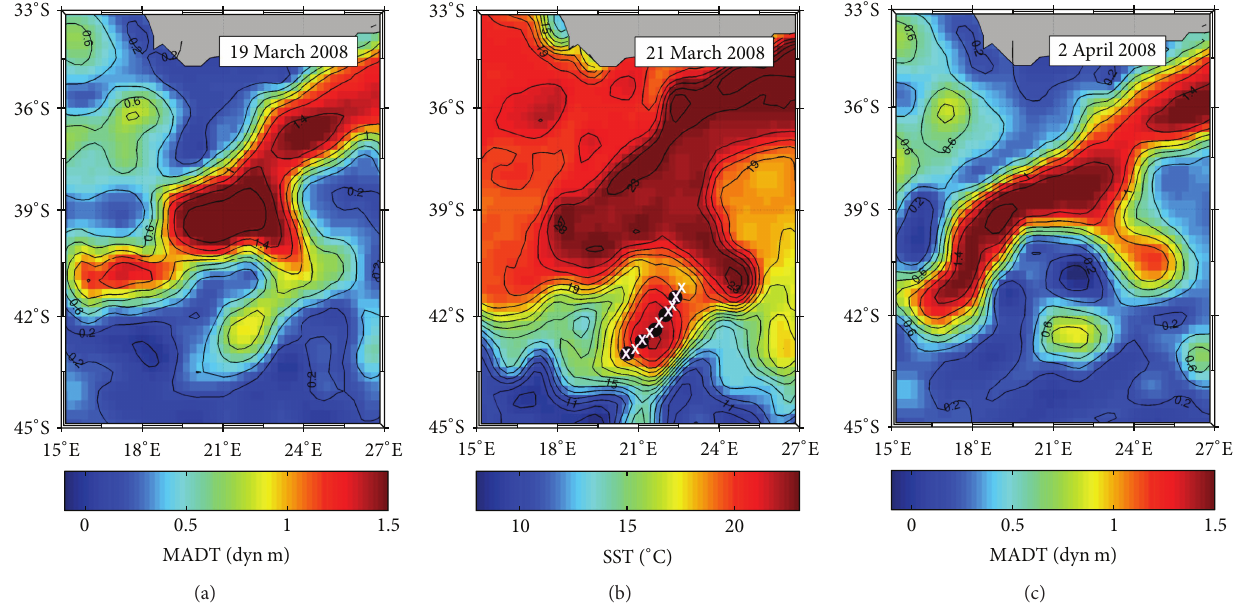
Figure 2: Maps of Absolute Dynamic Topography (MADT), snapshot for (a) 19 March 2008 and (c) 2 April 2008. AMSR-E SST is presented for 21 March 2008 (b) with location of XBT releases (white crosses) and radiosounding releases (black circles).